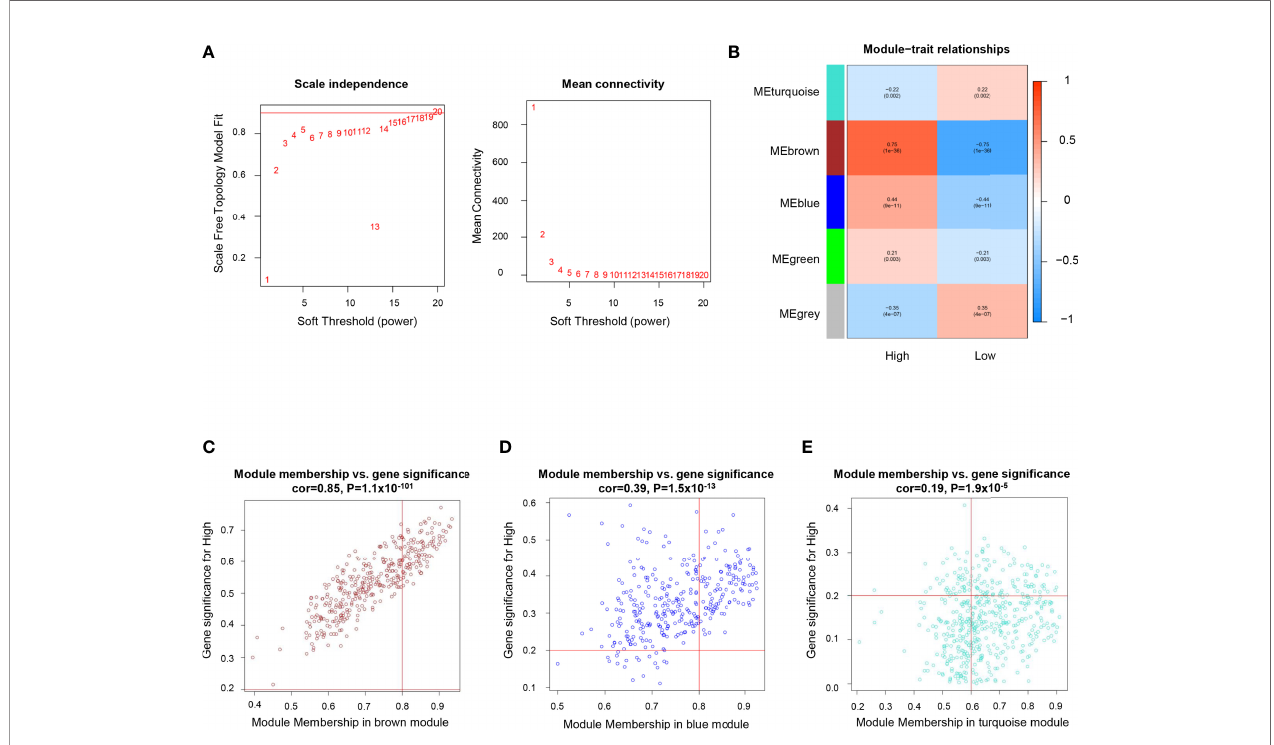
FIGURE 2 | Identi fi cation of genes related to high immune cell in fi ltration. (A) Determination of soft threshold by evaluating the scale-free topology fi t index (left) and mean connectivity (right). (B) Heatmap for the correlations of gene modules to immune cell in fi ltration. Correlations between module membership and gene signi fi cance values were presented in scatterplots for the brown (C) blue (D) , and turquoise (E) gene